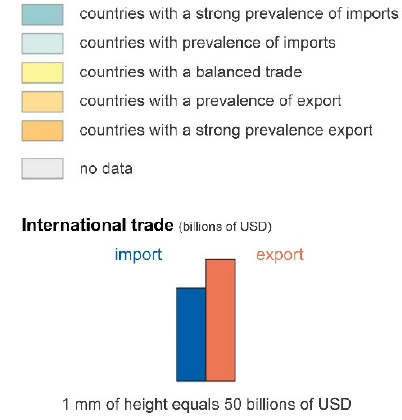
Figure 11. Legend for Task08 (translated into Figure 11 . Legend for Task08 (translated into English).